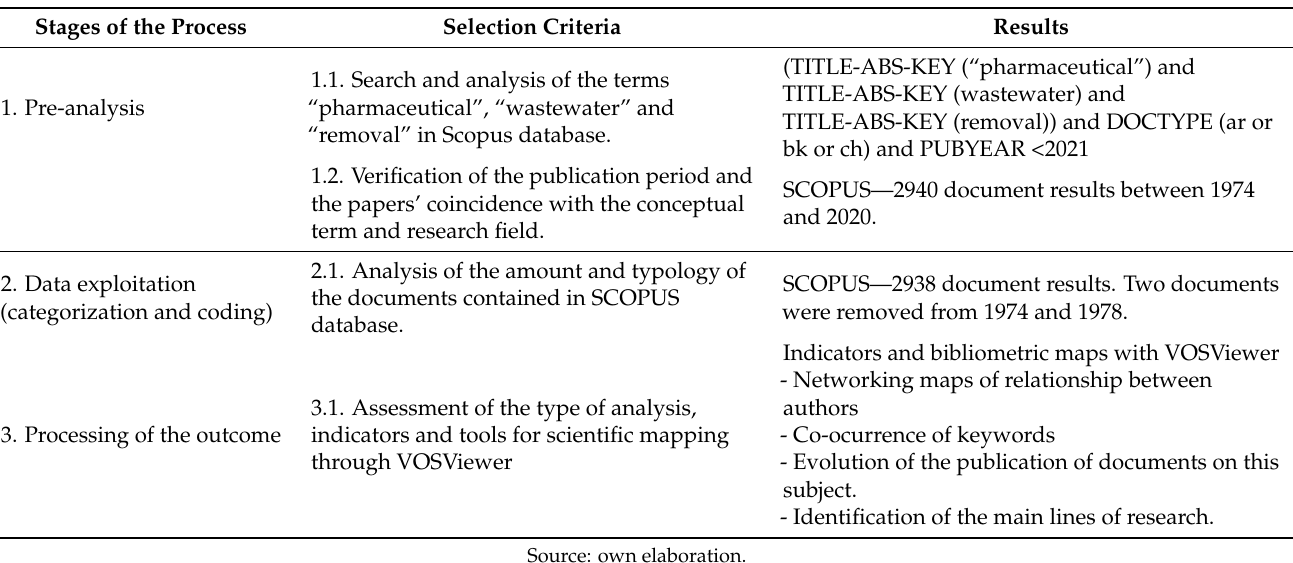
Table 2. Stages of bibliometric analysis process.